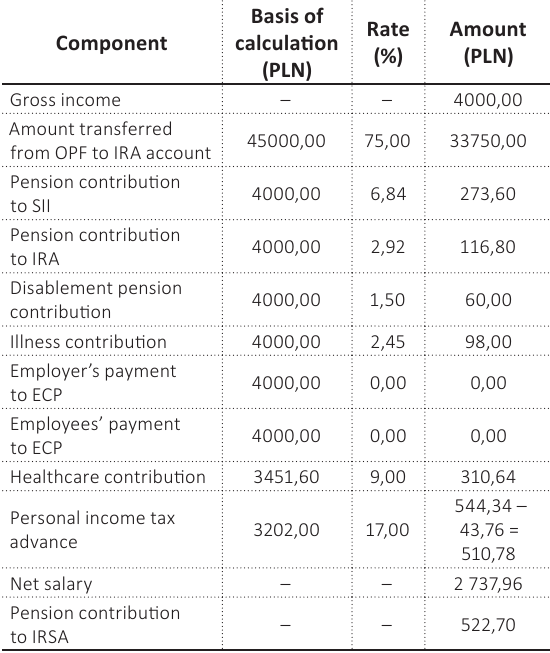
Table 12. Variant 4 – pension amounts after